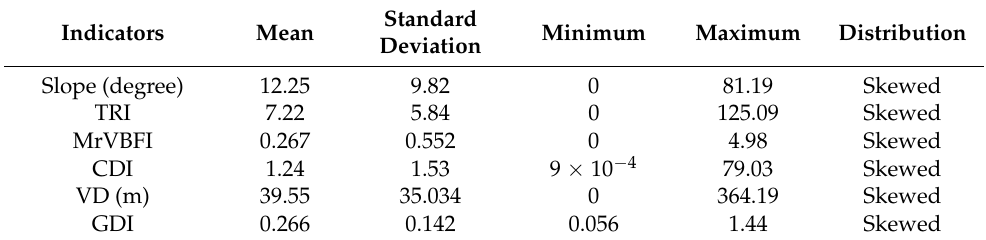
Table 5. Statistical summary of